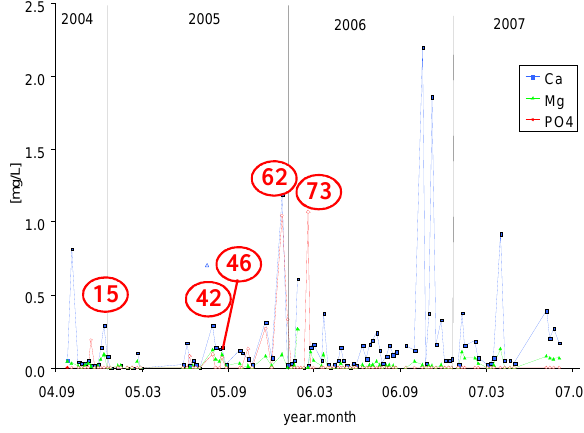
Figure 5: Fig. 5. Same as in Fig. 3, but for Ca, Mg, and PO 4